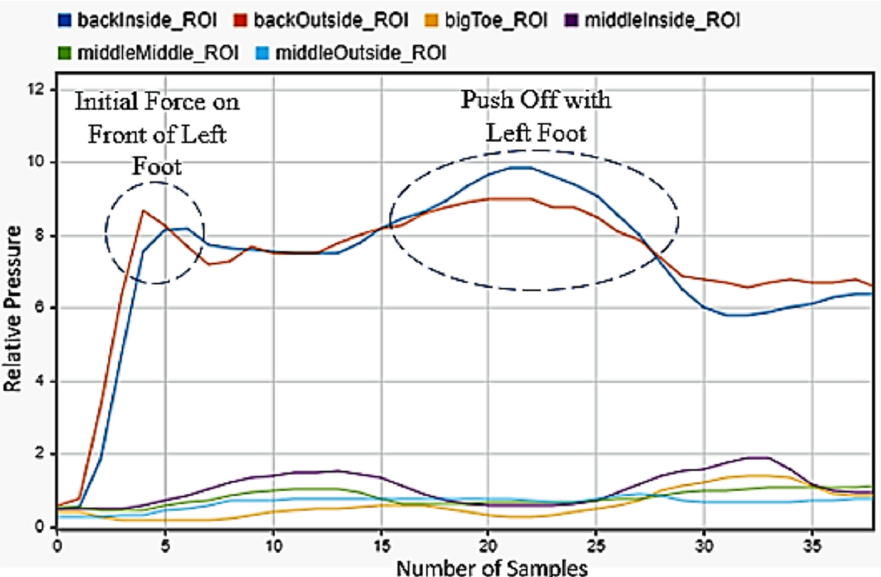
Figure 9. Stoop with left foot forward sensor readings for the left